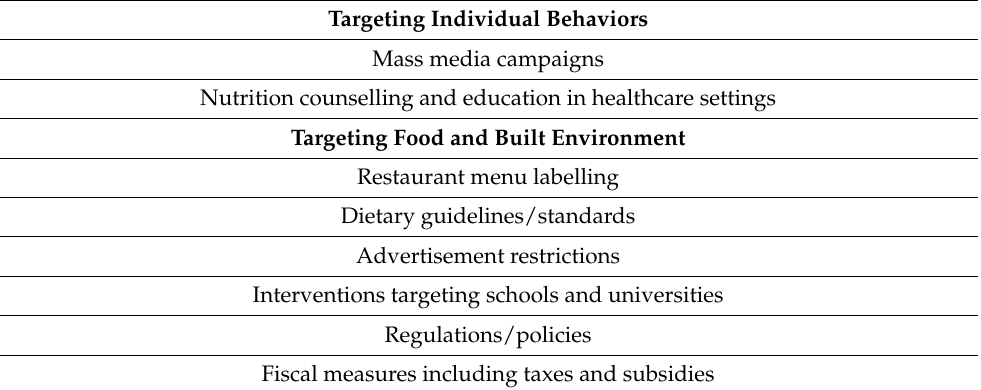
Table 1. Examples of population-wide interventions to combat